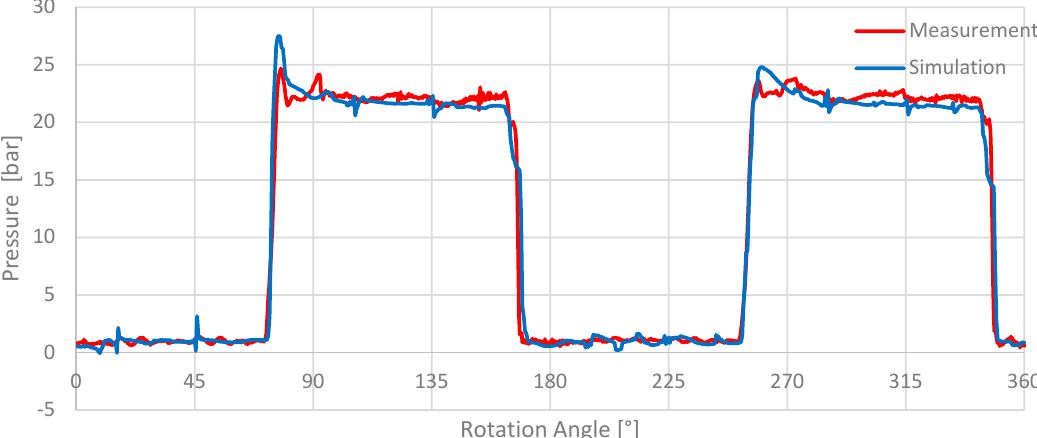
Figure 9. Monitored displacement chamber pressure during one rotation of the pump. Comparison of measurement and simulation at 2000 rpm and 20 bar delivery pressure.